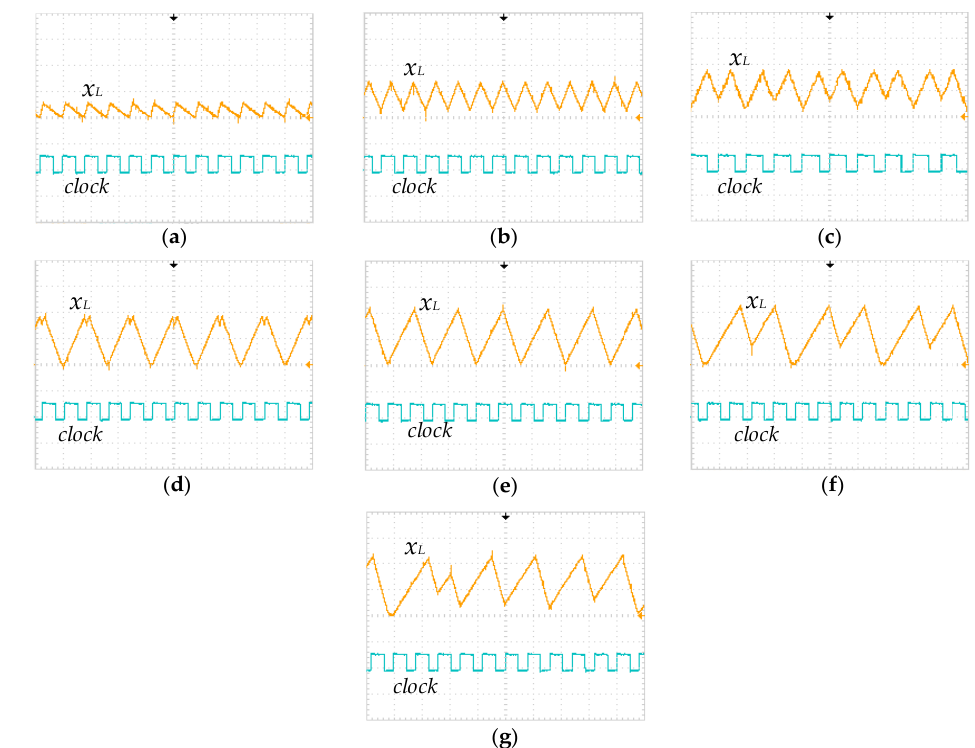
Figure 12. Experimental waveforms of inductor current x L and switching signal at ( a ) I ref = 0.20 A; ( b ) I ref = 0.50 A; ( c ) I ref = 0.85 A; ( d ) I ref = 1.00 A; ( e ) I ref = 1.17 A; ( f ) I ref = 1.20 A; and ( g ) I ref = 1.27 A.